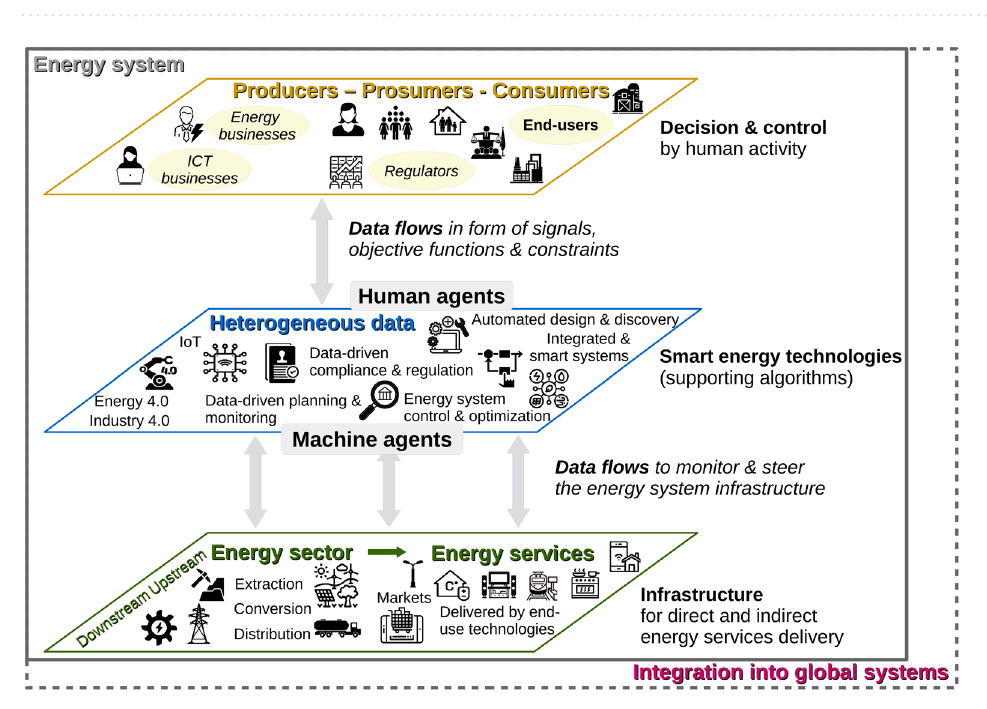
Figure 2. The energy system with human and machine agents at the center. The top layer details human actors in the energy sector, engaged in the production, distribution, and/or consumption of energy services. Their decisions and behaviors define the objectives and constraints of the energy system. This information is delivered through bilateral heterogeneous data bundles that are taken up by smart energy technologies to monitor and steer the energy system infrastructure (bottom